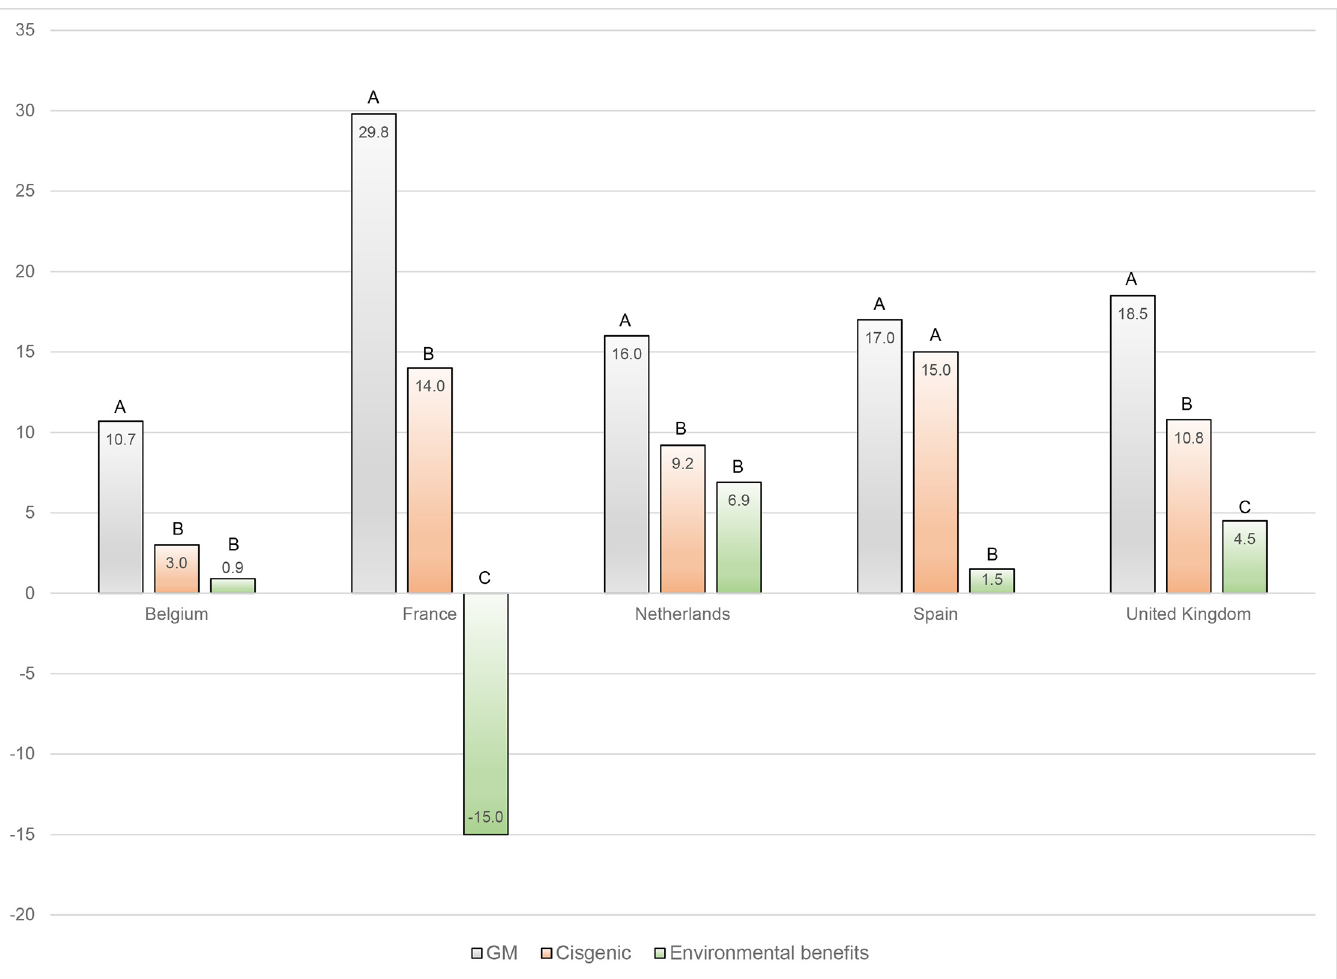
Fig 1. Willingness-to-pay [ € ] by country for conventional rice instead of rice labeled as GM, cisgenic or with environmental benefits. The bars represent the premium or discount that consumers are willing to pay for conventional rice in order to avoid rice labeled as GM (grey bars), as cisgenic (red bars) or as having environmental benefits (green bars). All results are in Euros. The UK participants answered in GBP but the values above are converted to Euros using an exchange rate of 0.8431 GBP per Euro. For a given country, bars identified by the same letter are not statistically different from one another at the (p < 0.05) significance